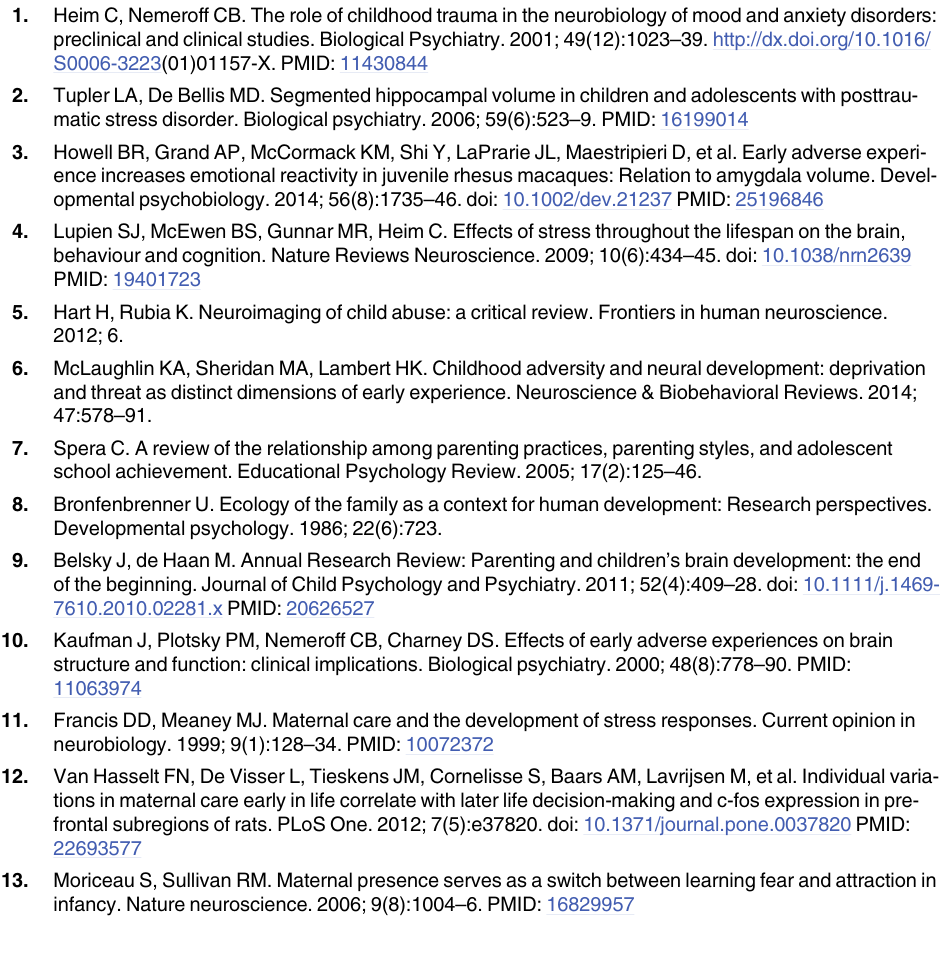
S1 Table. Psychopathology characteristics of the sample. S2 Table. Average SD (mm) for each ROI based on individuals scanned at both sites for reliability